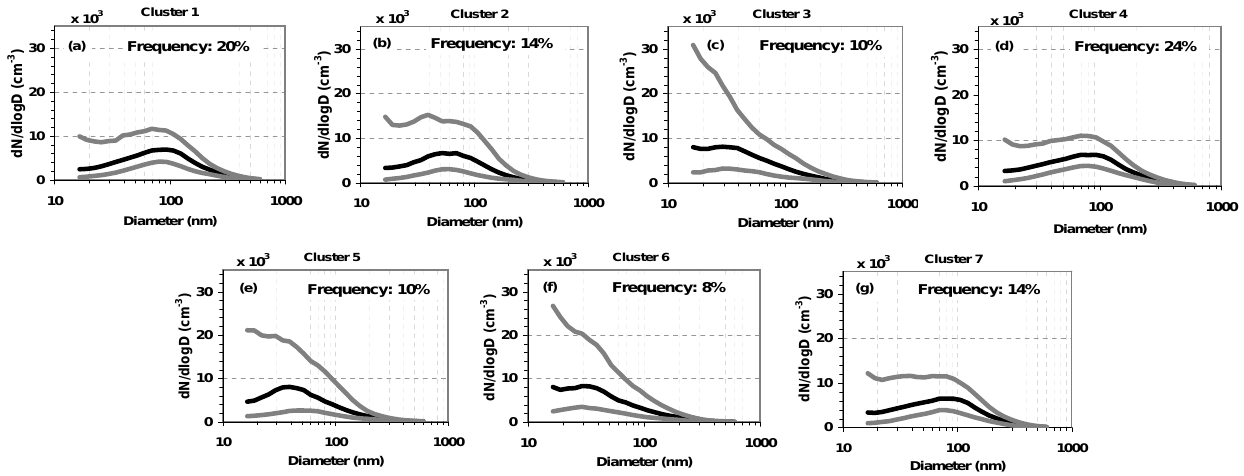
Fig. 9. Median particle number size distribution, averaged over the seven back-trajectory clusters (black) and the 16th and 84th percentiles (grey). The frequency of each cluster over the study period is also shown (Table 3). Cluster 1 is representative of desert-dust, clusters 2, 3, 5 and 6 of marine air mass origin and clusters 4 and 7 of continental air mass